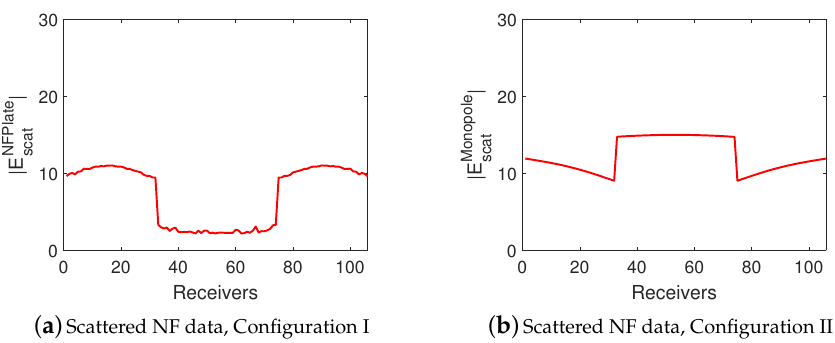
Figure 10. Separation resolution study. Scattered NF data for ( a ) Configuration I and ( b ) Configuration